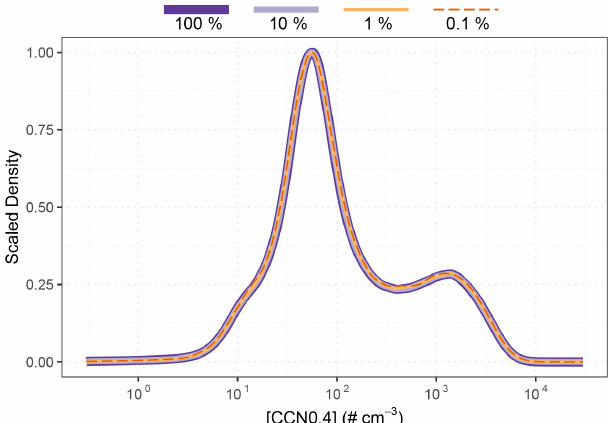
Figure 3. Scaled Gaussian kernel density estimate for [CCN0.4] for the training set (dark purple) and each of its subsets (10%: light purple; 1%: light orange; 0.1%: dark orange). The distributions are almost identical. A 1% randomly sampled subset is used to train the